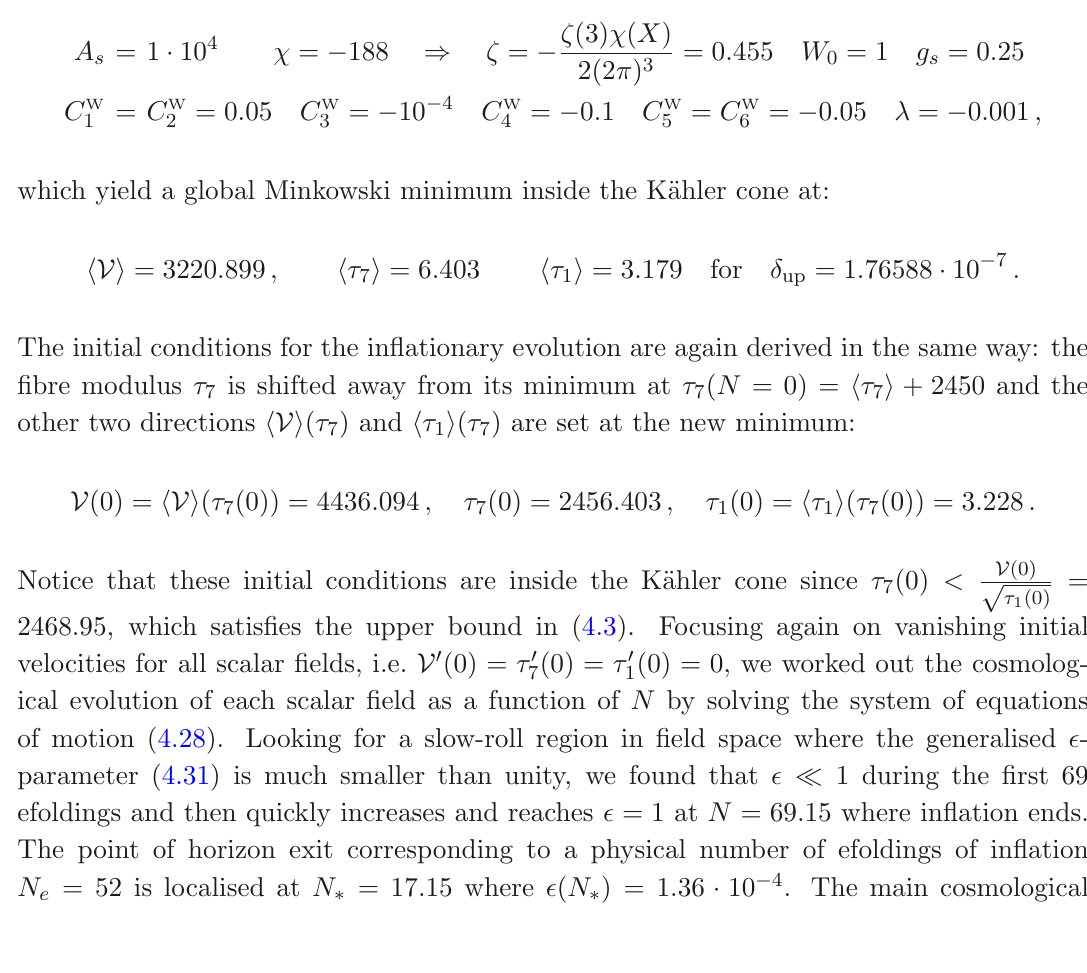
in GeV units from horizon exit to the final settling into the global 3 / 2